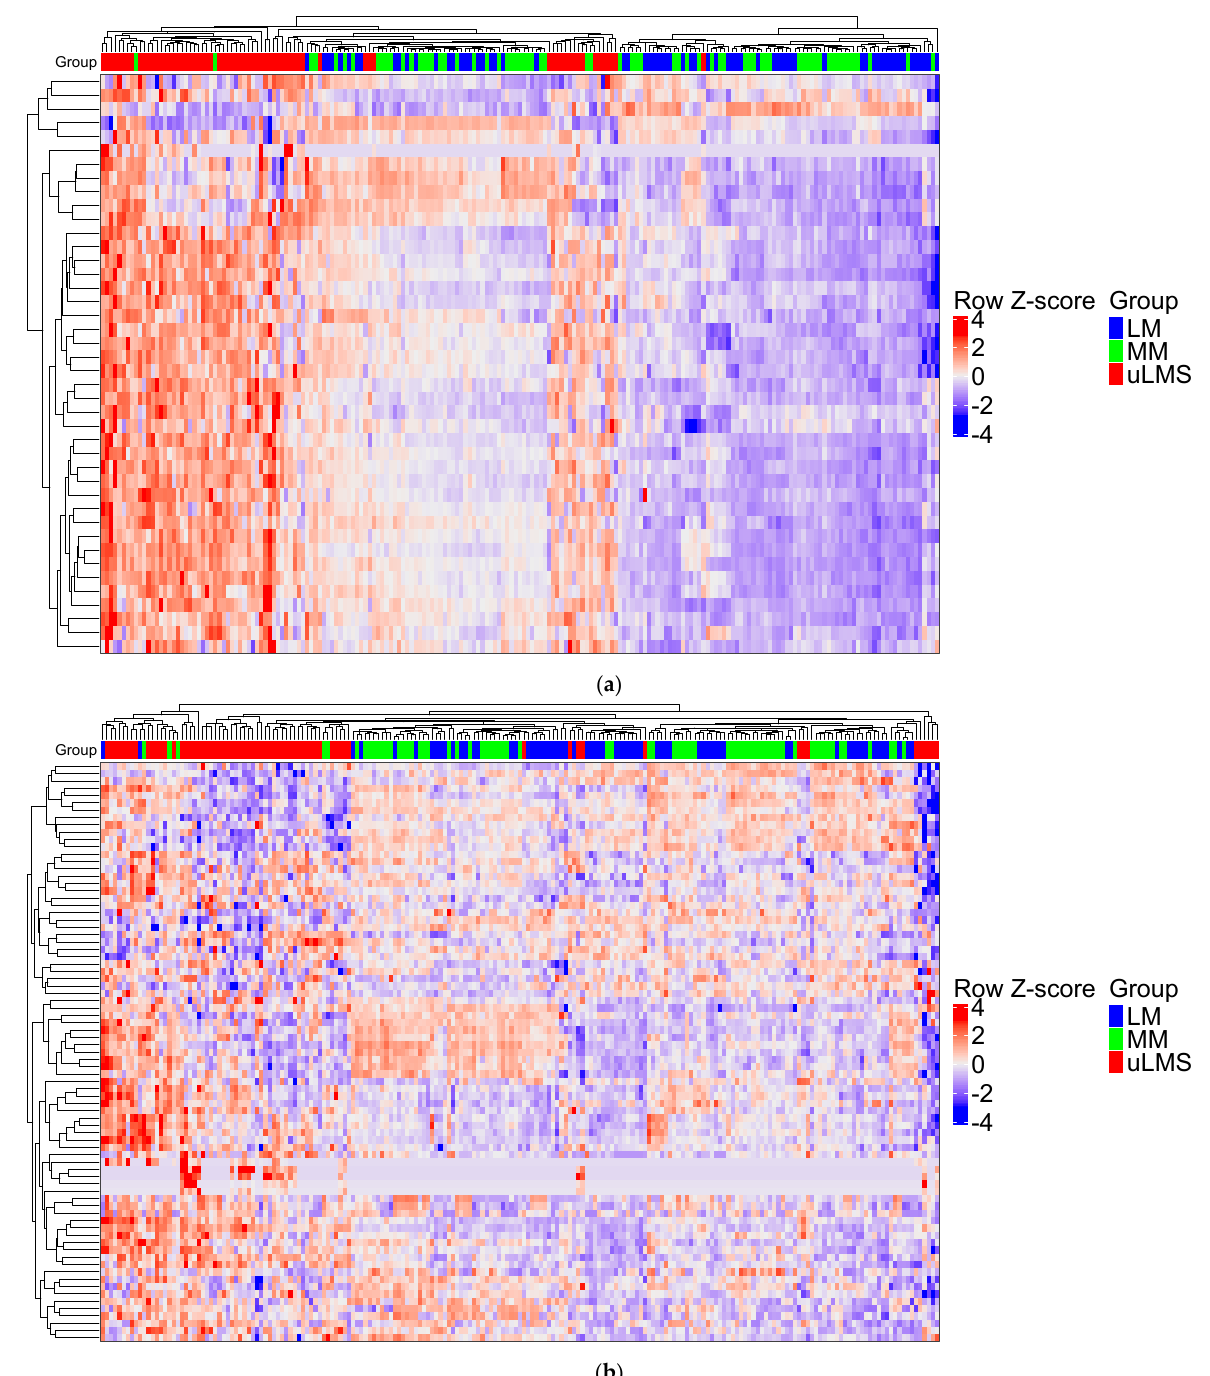
Figure 2. ( a ). Unsupervised clustering based on KEGG PROTEASOME pathway from MSigDB database. ( b ) Unsupervised clustering based on REACTOME INTERFERON GAMMA SIGNALING pathway from MSigDB database as a gene set. LM: Leiomyoma; uLMS: uterine Leiomyosarcoma; MM: myometrium .